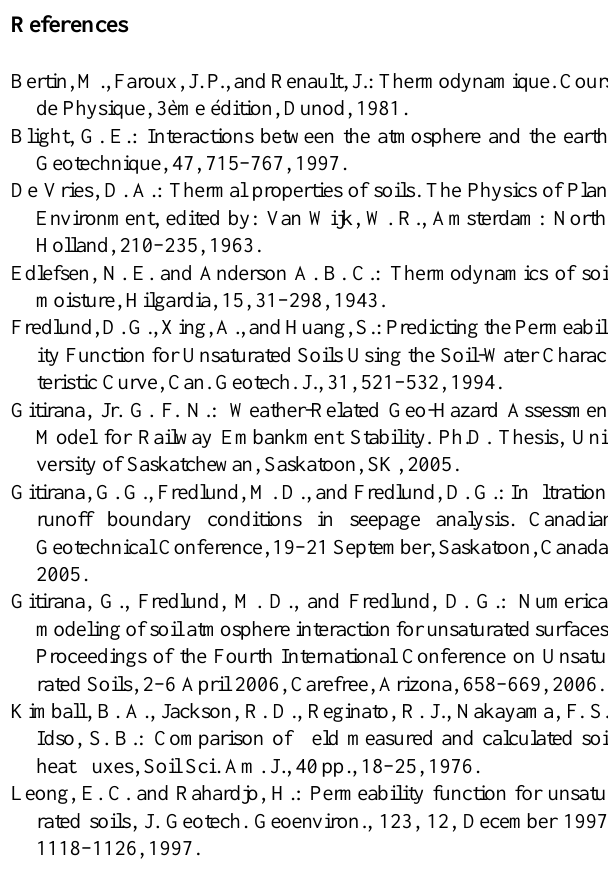
Figure 13d . Influnce the soil type on the variation of the suction at the soil surface Fig. 13d. Influnce the soil type on the variation of the suction at the soil